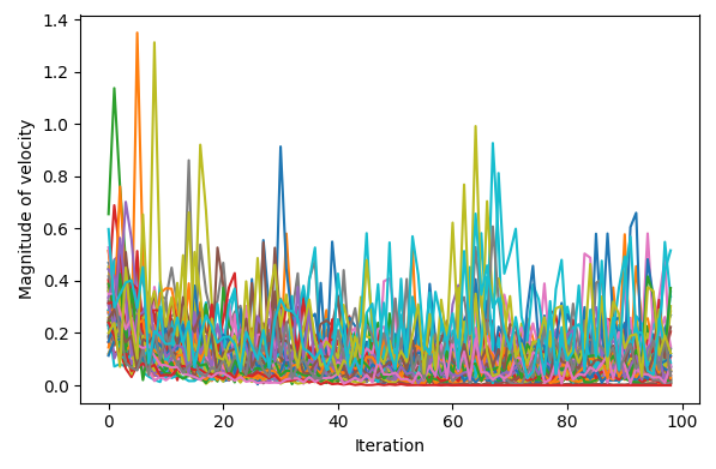
Figure 17. Velocity magnitudes for each of the particle position updates throughout the optimisation process using no weight inheritance